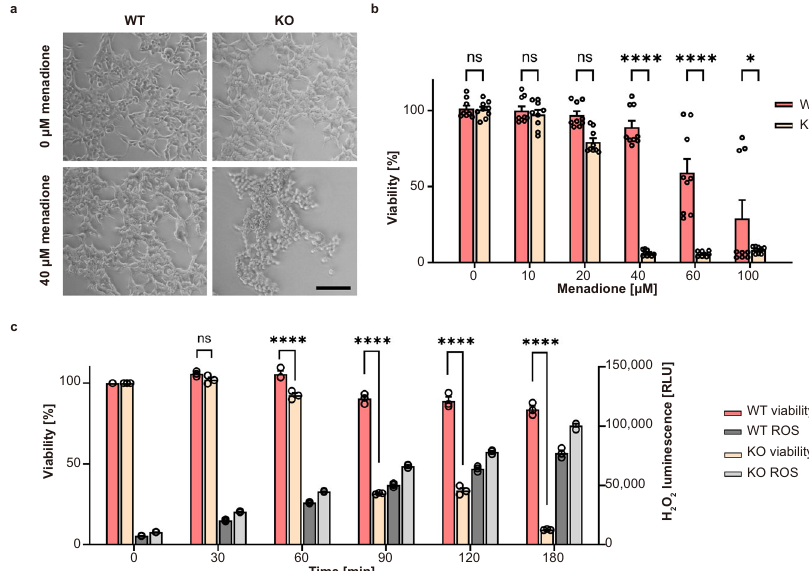
Fig. 5 | Effect of menadione-induced oxidative stress on WT and C12orf29-KO cells. a Light microscopy of HEK293 WT and C12ORF29 -KO cells. The cells were treated with 40 μ M menadione for 3h or only with the carrier as control (0 μ M menadione).Scalebarsare100 μ m. b CellviabilityofHEK293WTand C12ORF29 -KO cells after 3h treatment with different menadione concentrations. Hollow circles representindividualdatapointsfor n =9biologicalreplicates.Errorbarsrepresent the ± SEM. Signi fi cance was calculated by two-way ANOVA with Sidak ’ s multiple